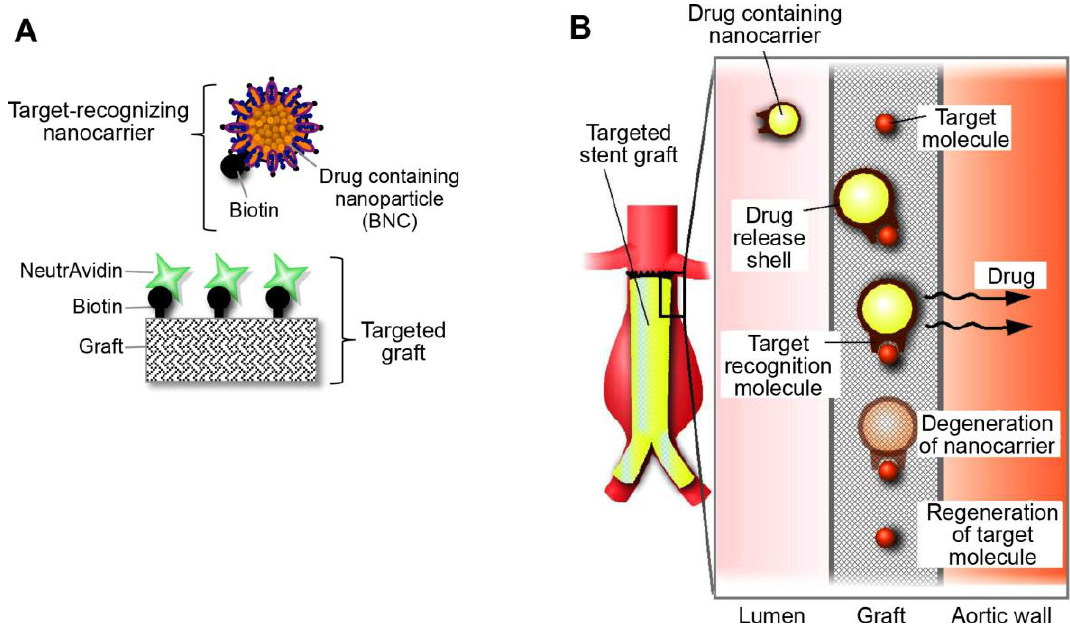
Figure 1. Concept of a novel hybrid drug delivery system. ( A ) Diagram shows the configuration of the system. The targeted graft is decorated with biotin–neutravidin complexes. Neutravidin serves as the target. ( B ) Diagram shows the function of the system. The system is charged by injecting drug-containing nanocarriers. In the aorta, nanocarriers recognize and bind to the target molecules attached to the graft. After releasing the drug at the site of the aneurysm, the nanocarrier degrades, and the target molecules are regenerated.